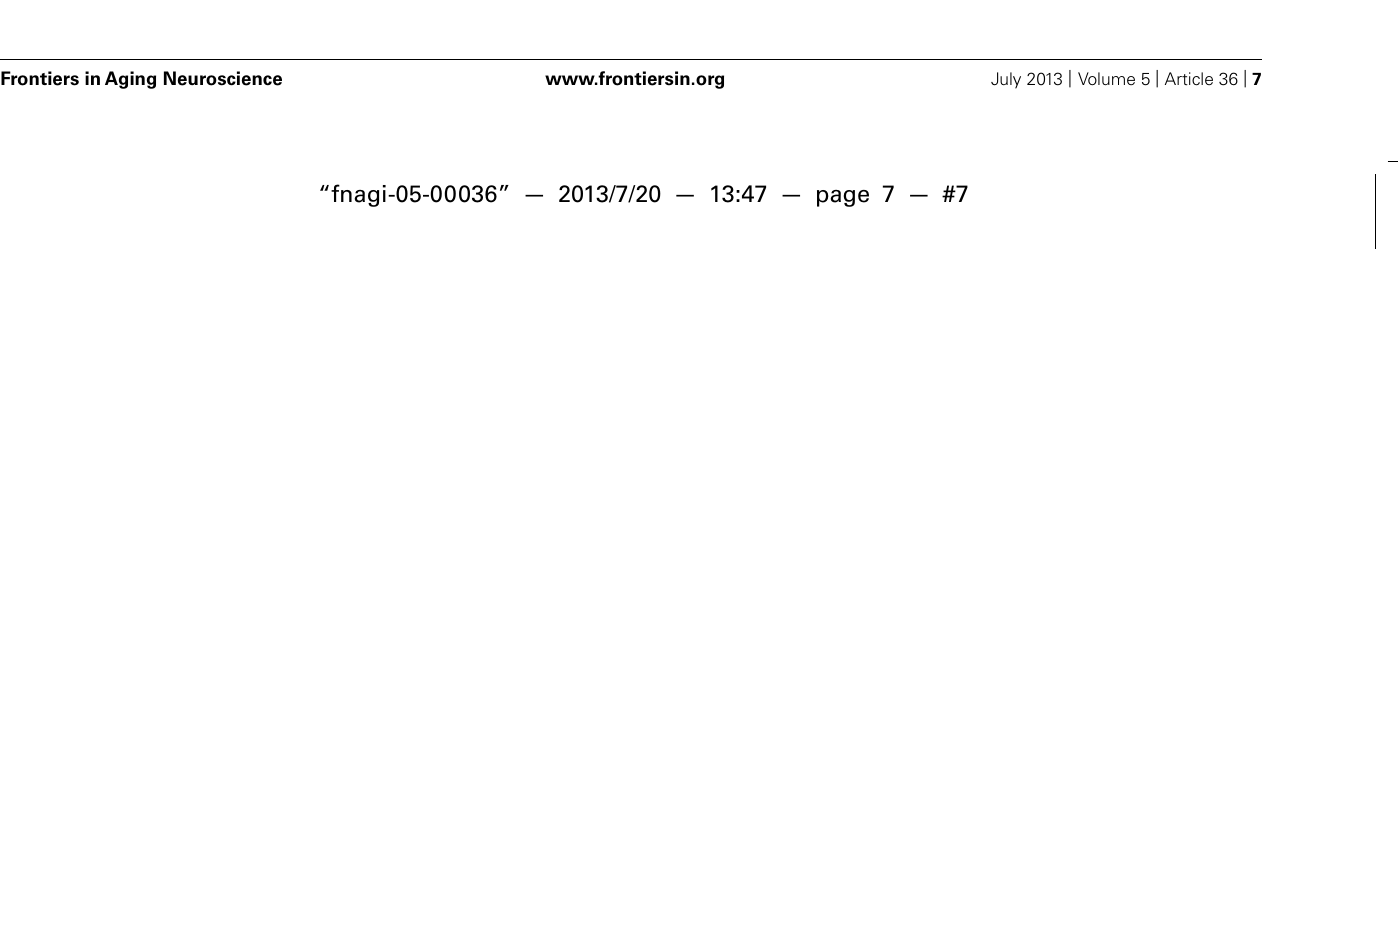
FIGURE 2 | Schematic overview of molecular targets of SIRT3 and the role in regulating metabolism in mitochondria.